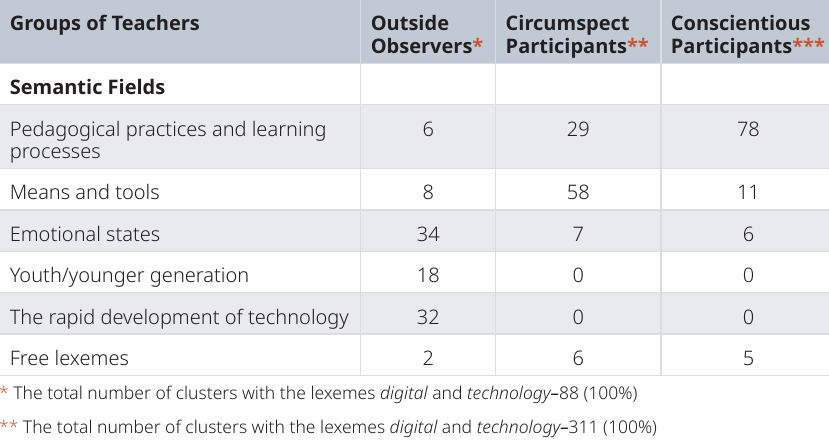
Table 5. Summary of the findings regarding the semantic fields as indicating teachers’ perceptions of school digitalization. Groups of